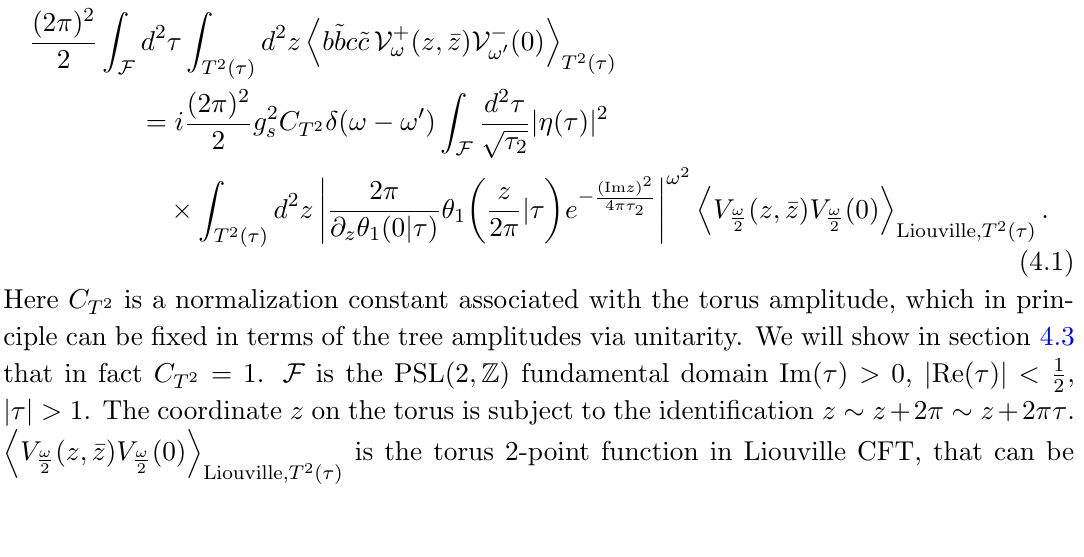
Figure 2 . Numerical results for the real and imaginary parts of the string amplitude for (cid:0) i A (0) (red dots) in comparison to the matrix model answer (blue dashed line) for ! 2 R > 0 + i(cid:15) and ! 1 = ! 2 = ! 3 = != 3, with (cid:15) = 0 :